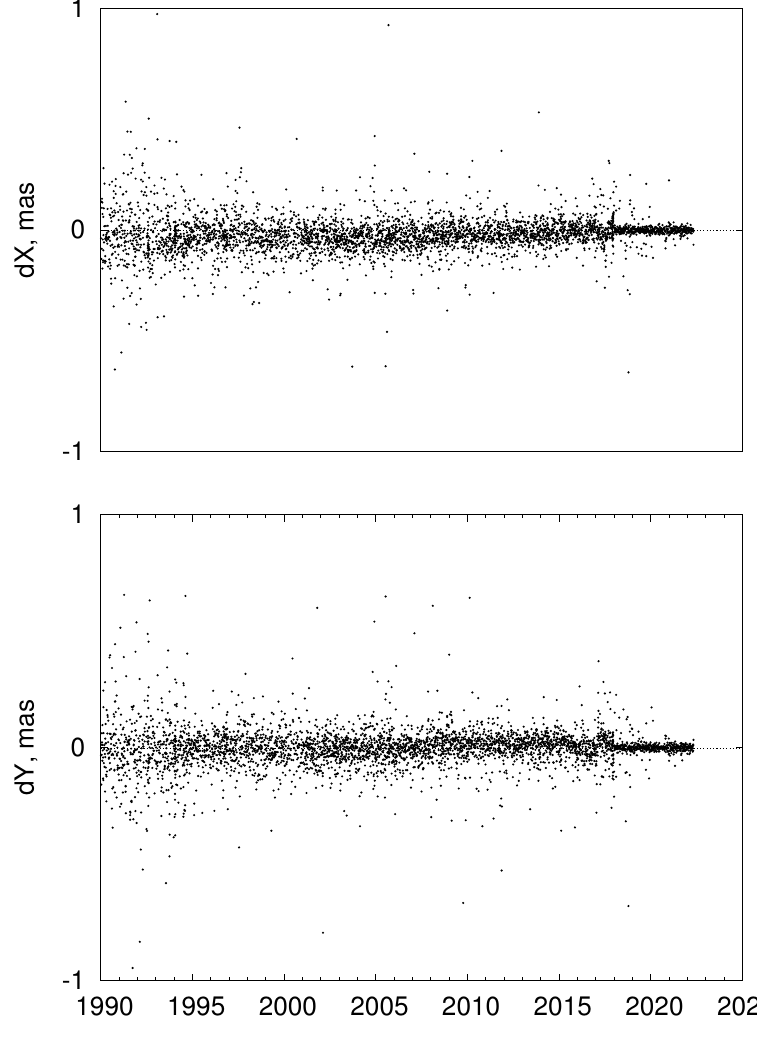
Figure 4. Differences between the IVS and IERS C04 CPO series (IVS minus